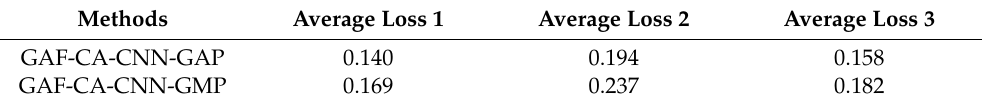
Table 3. The average loss of Global Average Pool and Global Maximum